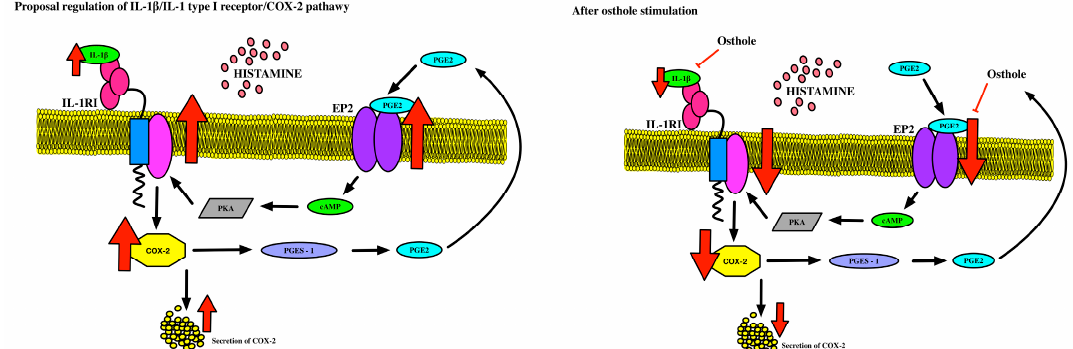
Figure 6. Simplified pathway of the idea of system underlying regulation of IL-1RI: ( A ) in children with diagnosed allergies, and ( B ) after osthole stimulation. IL-1 β is associated with a large liking toward receptor type I and stimulated COX-2 expression, and after that, secretion. This can be allowed to alter PGE 2 increases activity of EP 2 receptor and activate the cAMP messenger. This likely stimulates PKA, which can repeatedly stimulate IL-1RI expression, which signifies possible positive mechanisms for this pathway. Osthole successively decreases the amount of IL-1 β , decreases COX-2 expression/production, and also EP 2 expression, which creates a possible dangerous spiral in patients with allergies (scheme based on Machado-Carvalho et al. 2017 with own modifications [32]).